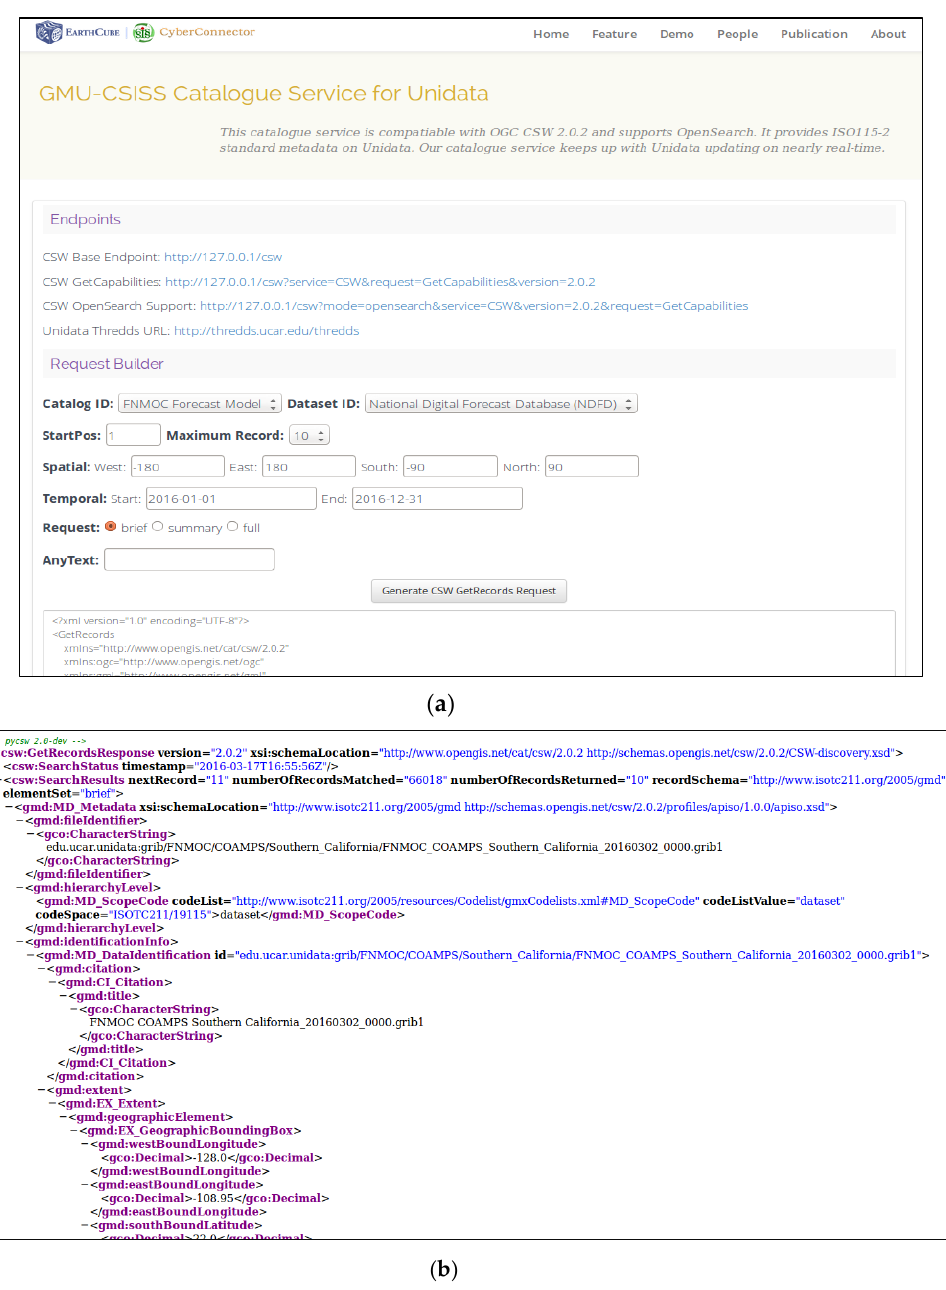
Figure 8. ( a ) CSW request builder for querying Unidata IDD data; ( b ) XML-encoding response of the CSW service.